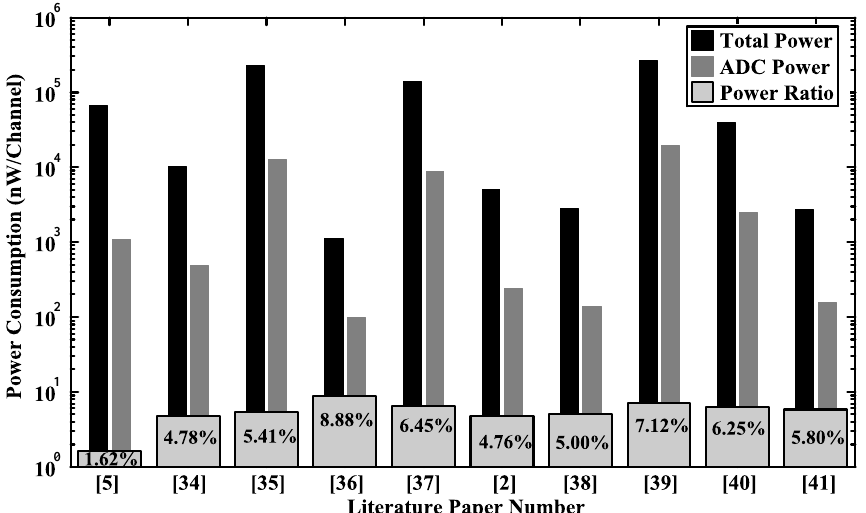
Figure 5. The total power consumption of the ADC block and its power ratio [2,5,34–41]. The power ratio is referred to as the ADC power divided by the total sensor